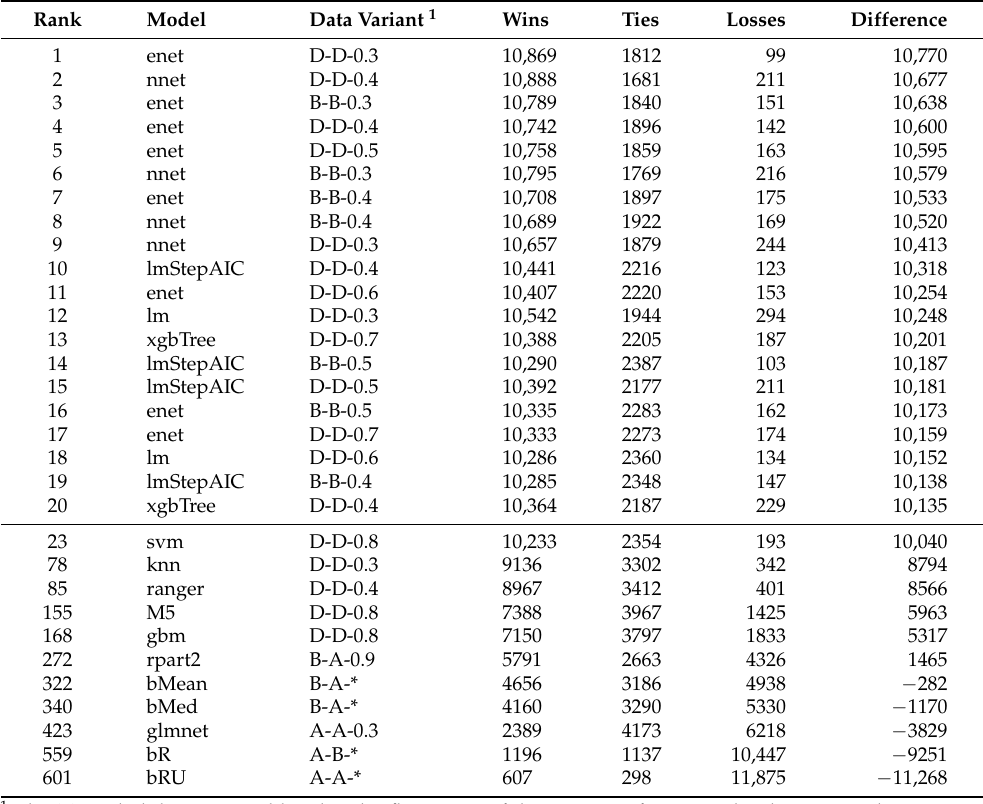
Table 8. Summary of the performance of the best combinations of models and data